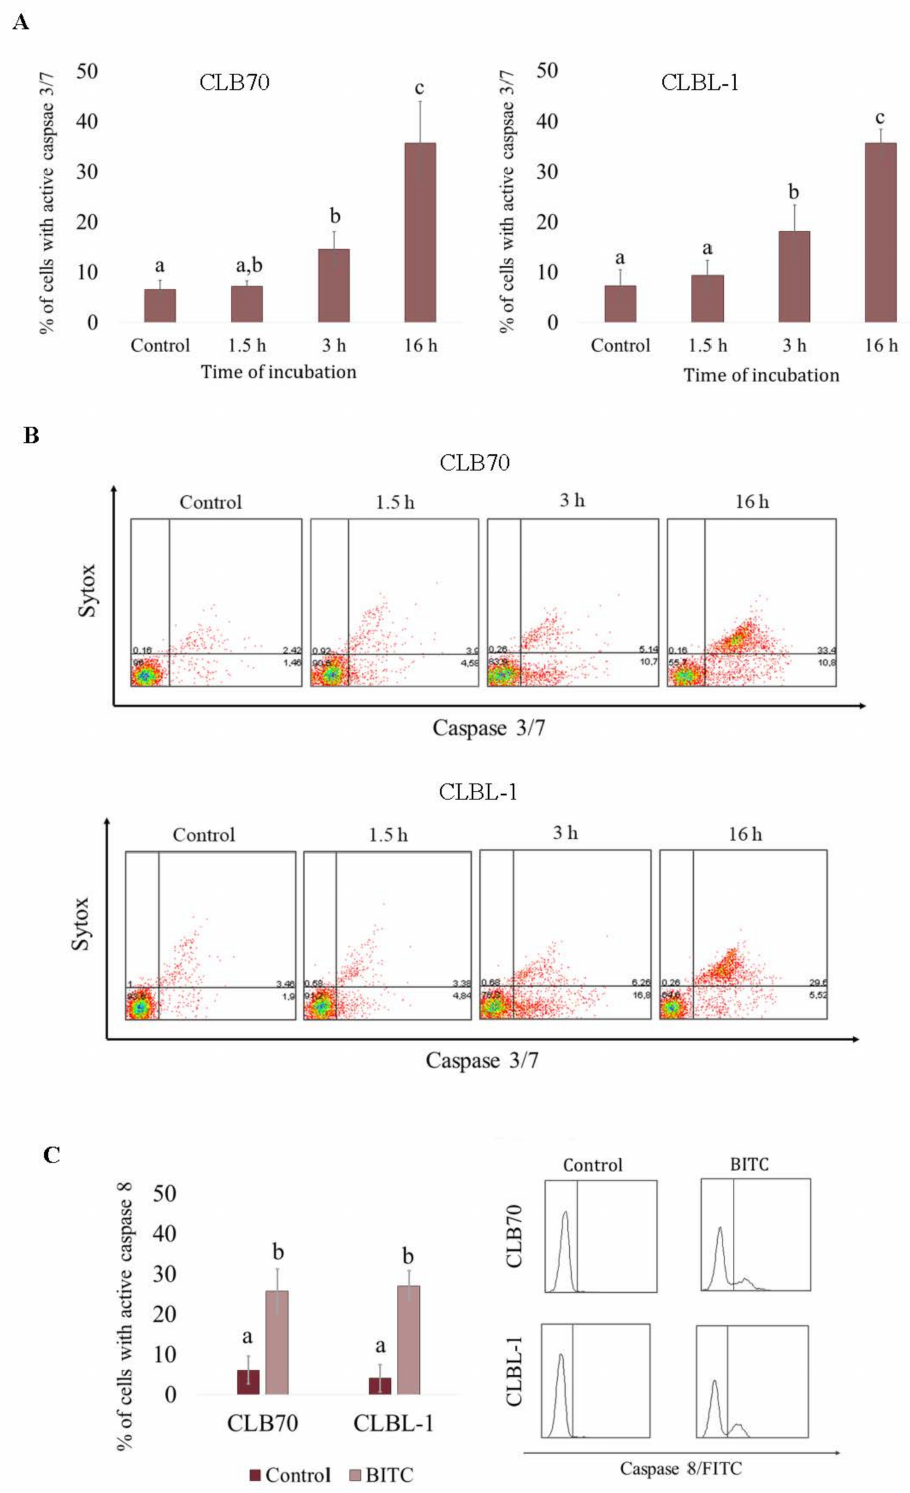
Figure 4. Activation of caspases in CLB70 and CLBL-1 cells after treatment with BITC. ( A ) Activation of caspase 3/7 in CLB70 and CLBL-1 cell lines was investigated in the cells incubated with BITC (4 µ M) for 1.5, 3 or 16 h. The number of cells with active caspase 3/7 was evaluated in flow cytometric analysis. ( B ) Representative dotplots showing cells double stained with CellEvent ® Caspase-3/7 Green Detection Reagent and SYTOX ® AADvanced™. ( C ) Percentage of cells with active caspase 8. Activation of caspase 8 was estimated in the cytometric analysis of cells stained with FITC-IETD-fmk after 16 h treatment with the compound. The values are means ± SD of three independent experiments. a,b,c Values with different letters in the superscript differ statistically ( p <